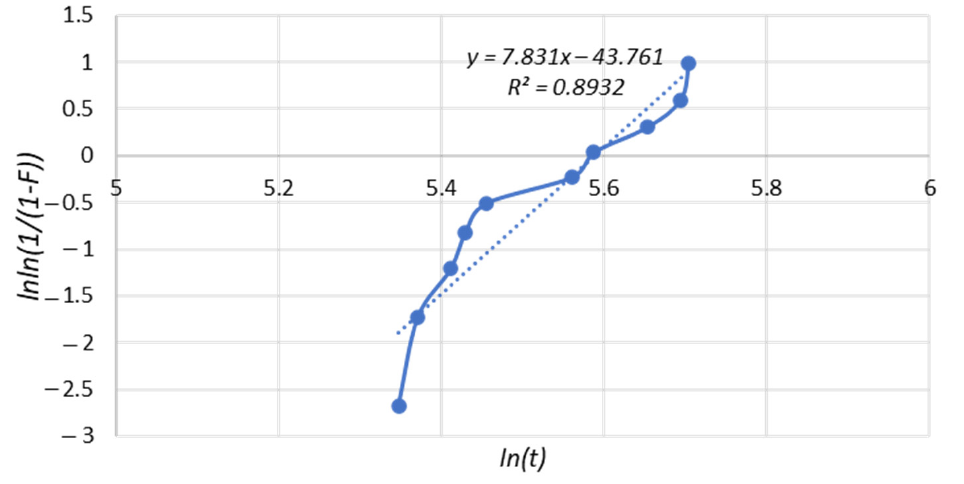
Figure 4. Weibull bi-parametric and regression line graph.